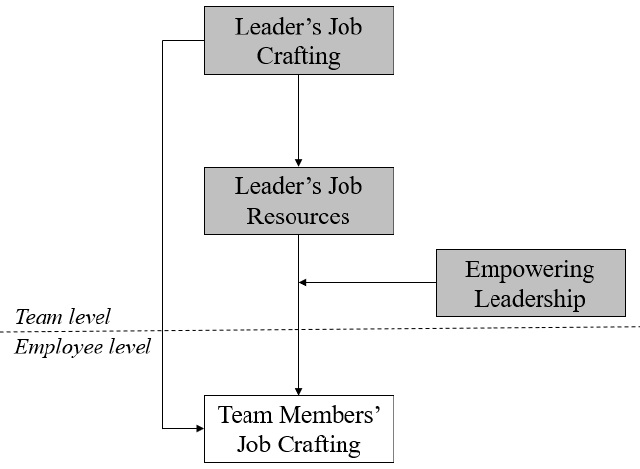
Figure 1. The hypothesized model.